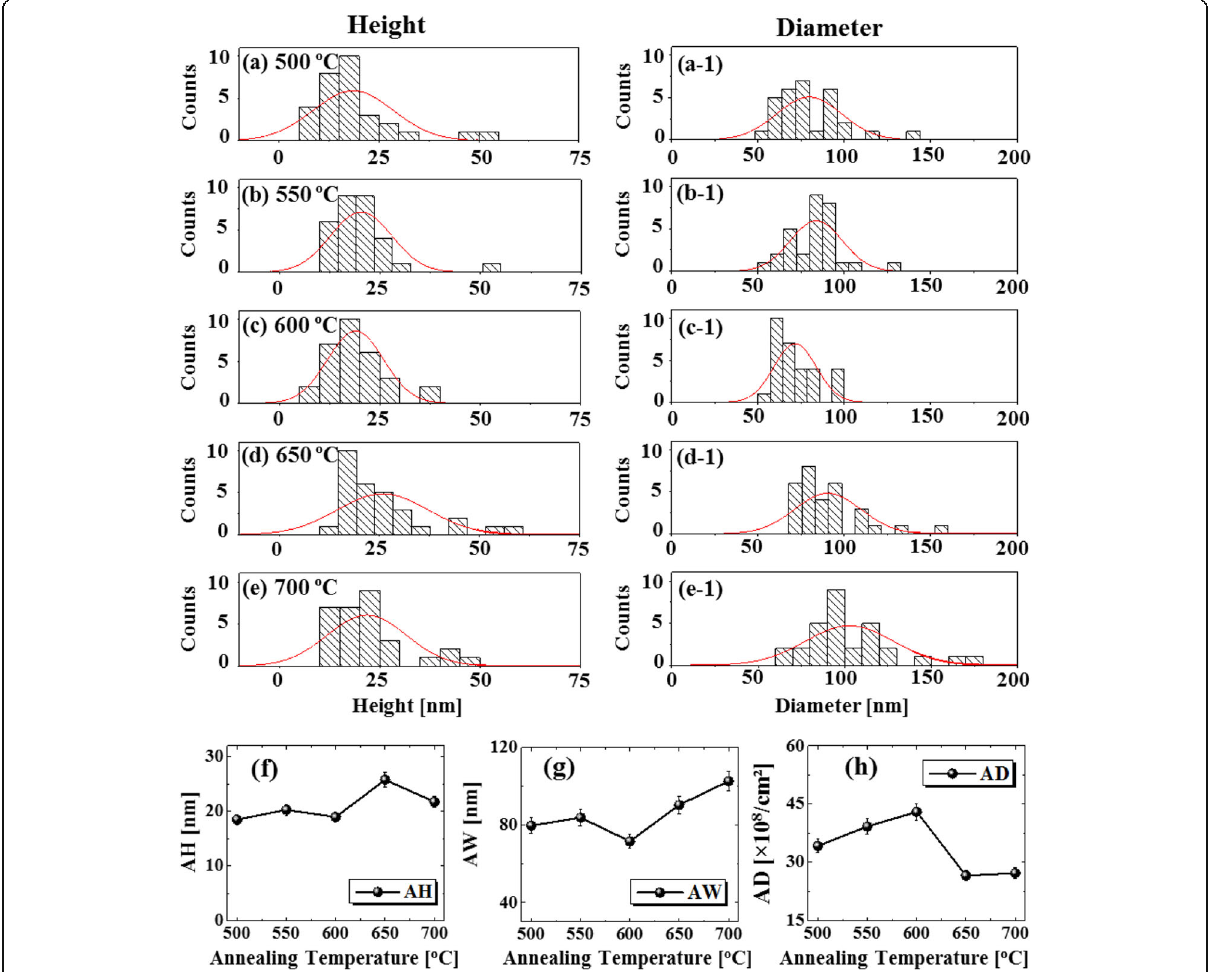
Fig. 7 Height in a – e and diameter in a-1 – e-1 distribution histograms of the Pd NPs fabricated between 500 and 700 °C with 5 nm deposition amount. f – h Summary of AH , AW , and AD with respect to the deposition amount. Error bars for the AH , AW , and AD are ±5% in f , g , and